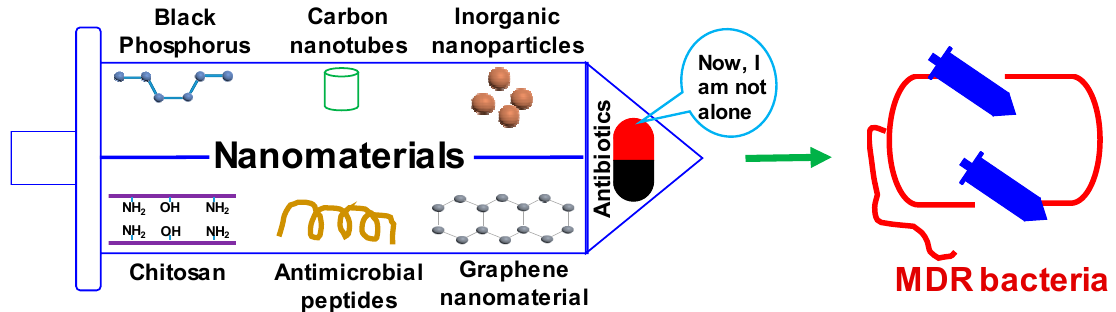
Figure 1. Schematic illustration of combating multidrug resistant (MDR) bacteria with nanomaterials.